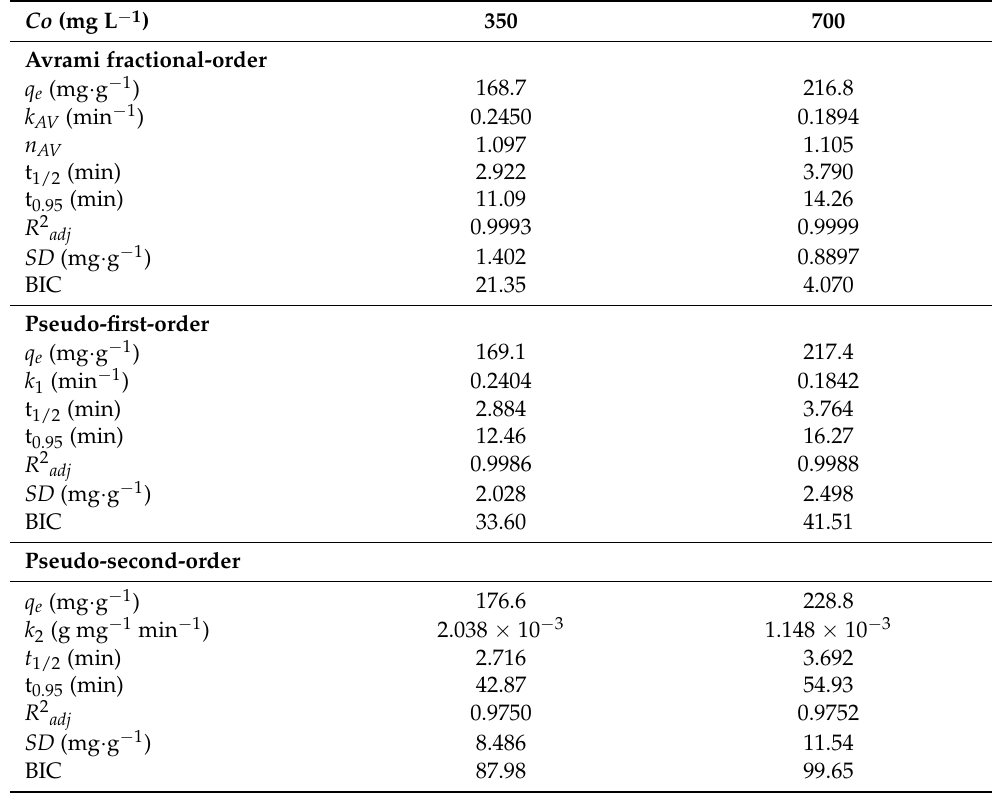
Table 3. Kinetic parameters for adsorption of catechol onto ABC material. Conditions: m 30 mg; pH 7.0; temperature 25 ◦